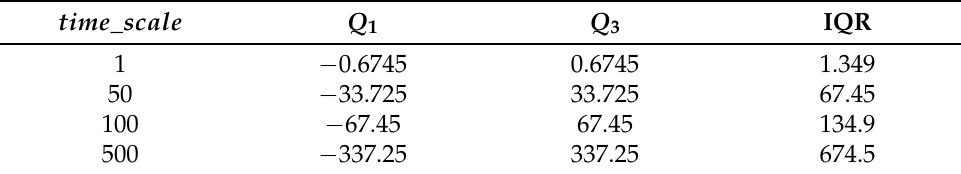
Table 2. Example of offset probability distributions starting from time_scale